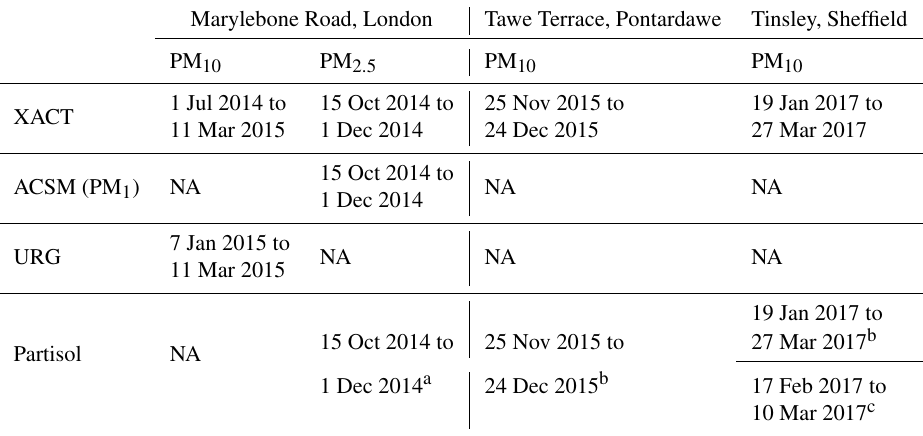
Table 1. Overview of sites and instrumentation used.